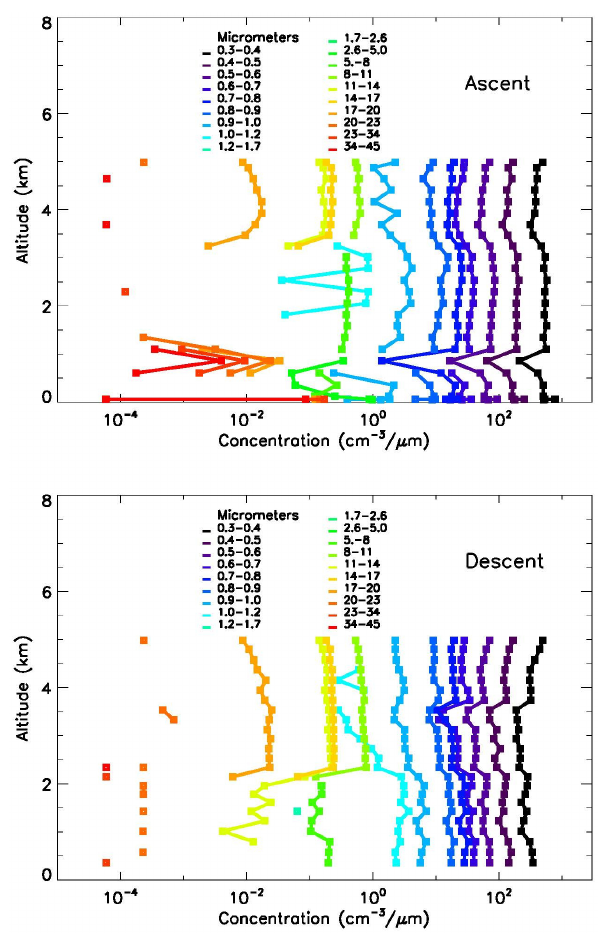
Fig. 11. Vertical profiles of aerosol concentration as a function of particle size inferred from the LOAC probe between 09:00 and 09:45UTC on 23 September 2012. Upper (lower) panel shows data collected during the ascending (descending) phase of the